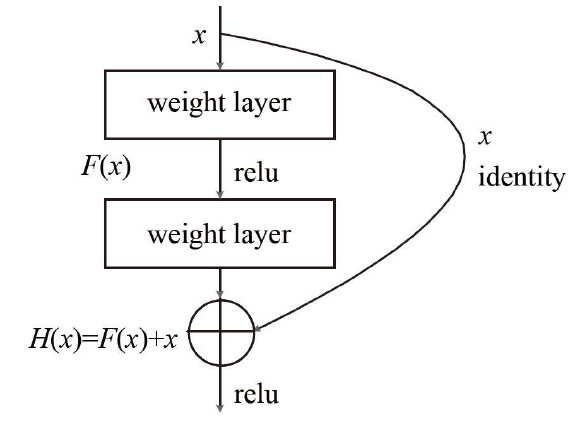
Figure 4. Residual network unit with the addition of a fast